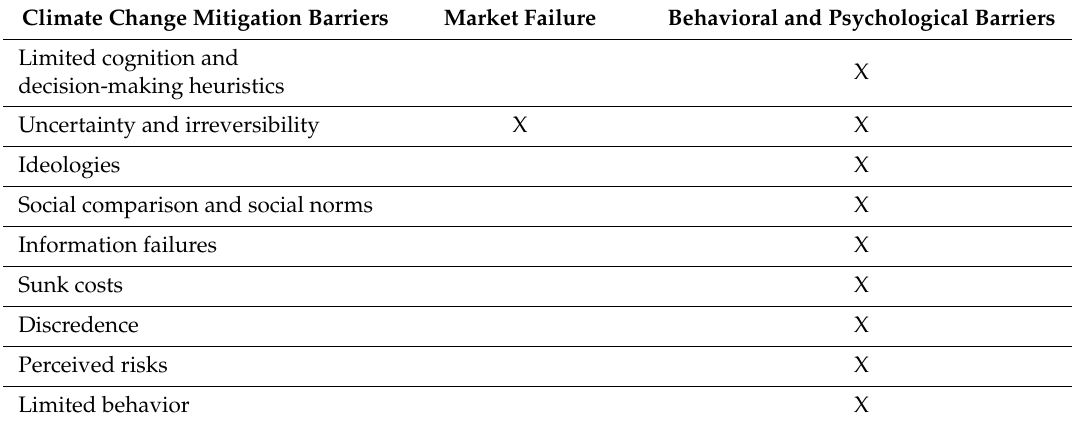
Table 5. Climate change mitigation barriers and market failures in